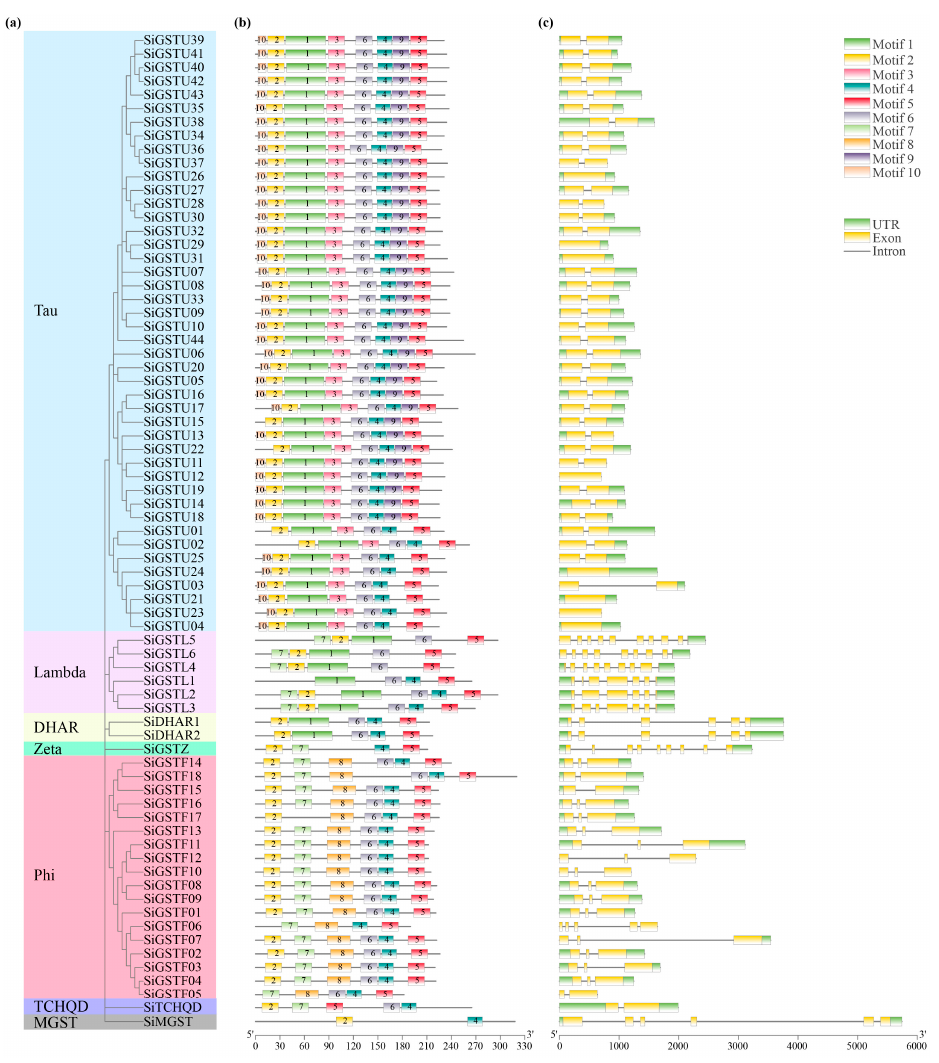
Figure 3. Gene structure and conserved motif of foxtail millet GSTs . ( a ) Neighbor-joining (NJ) phylogenetic tree based on SiGST protein sequences. ( b ) Conserved motif of SiGSTs . ( c ) Gene structure of SiGSTs .